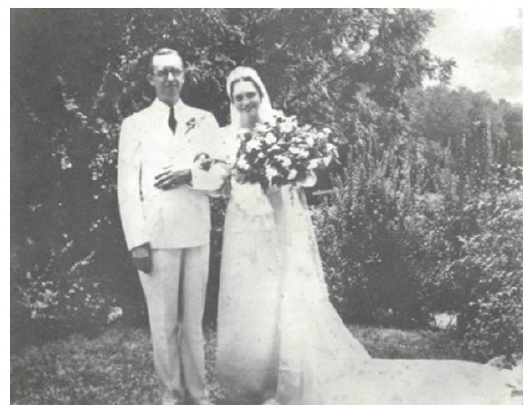
Figure 1. Leo Braselton Gorman’s maternal grandmother, Nan Wilson Bell, and her husband, Harrison “Brassie” Braselton, in Sparta after their wedding in 1937. Photograph courtesy of Nancy Braselton Gorman.